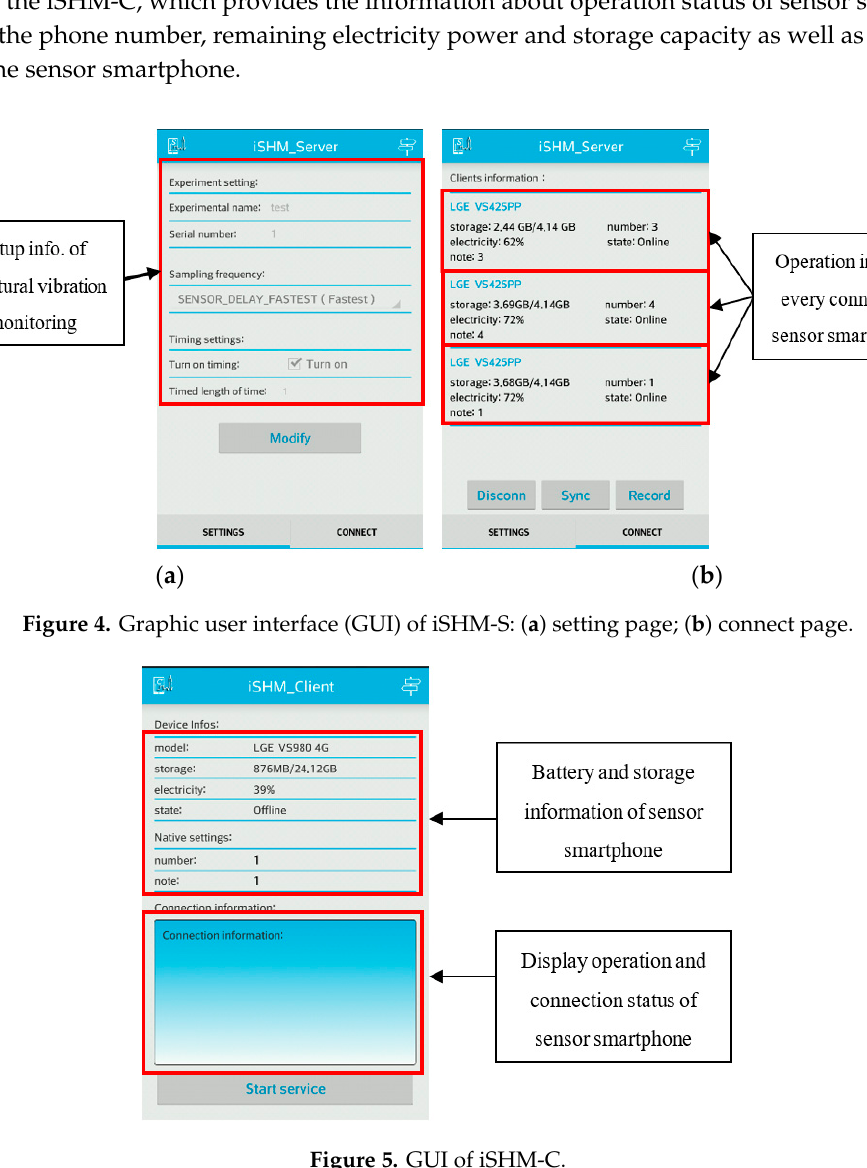
Figure 5. GUI of iSHM-C. Figure 5. GUI of